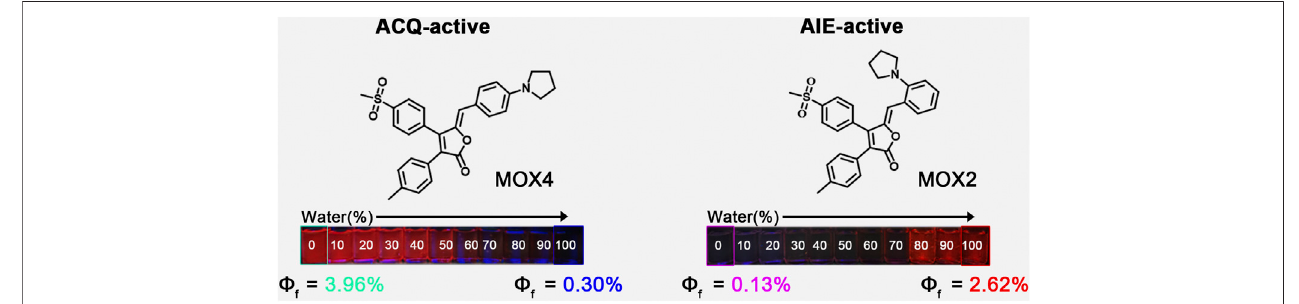
FIGURE 1 | A pair of new regioisomerized fl uorophores with opposite fl uorescent properties.